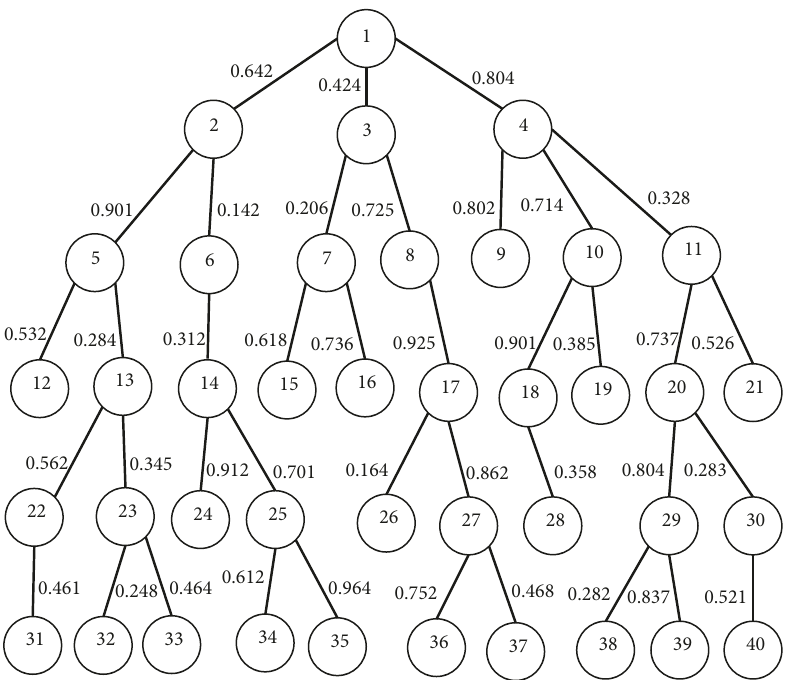
Figure 6: A tree example on which the proposed algorithm is applied where the edge labels are the operational probabilities.